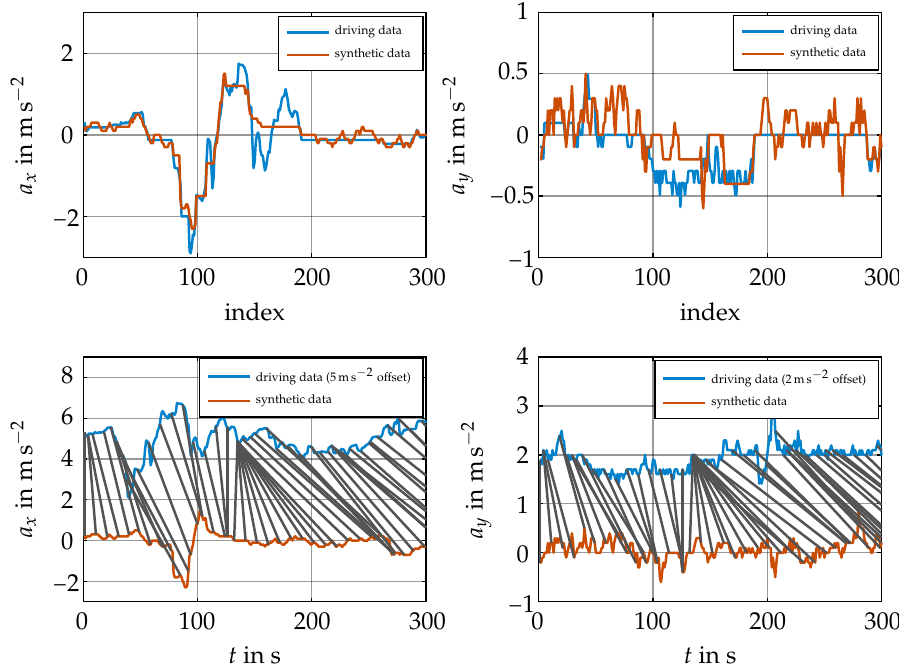
Figure 7. Example time series comparison using dynamic time warping (dtw).